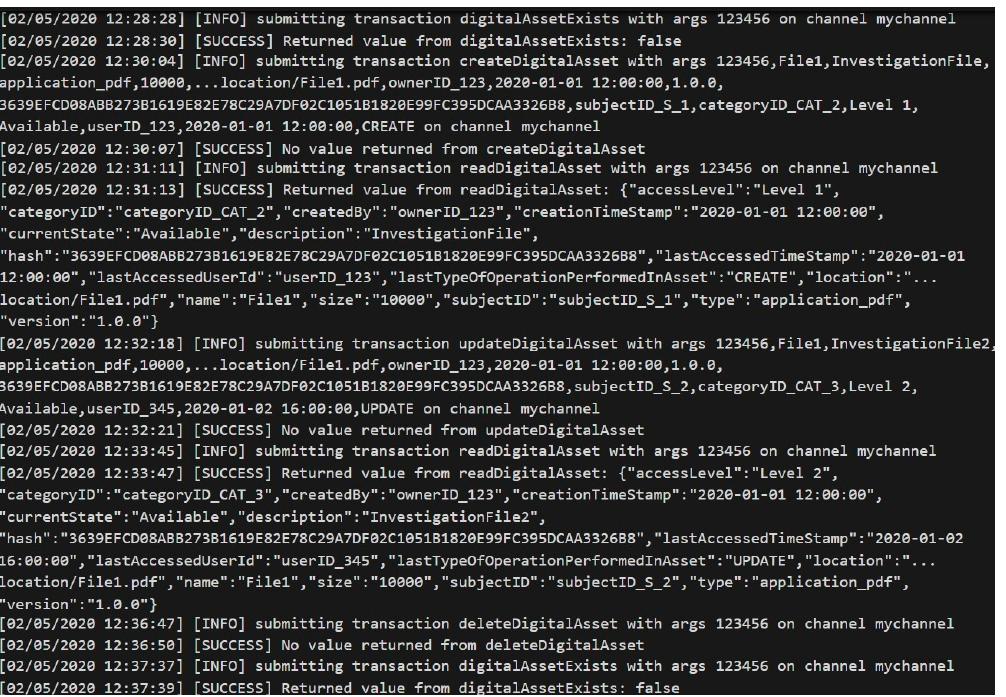
Figure A3. Logs of the smart contracts execution tests.